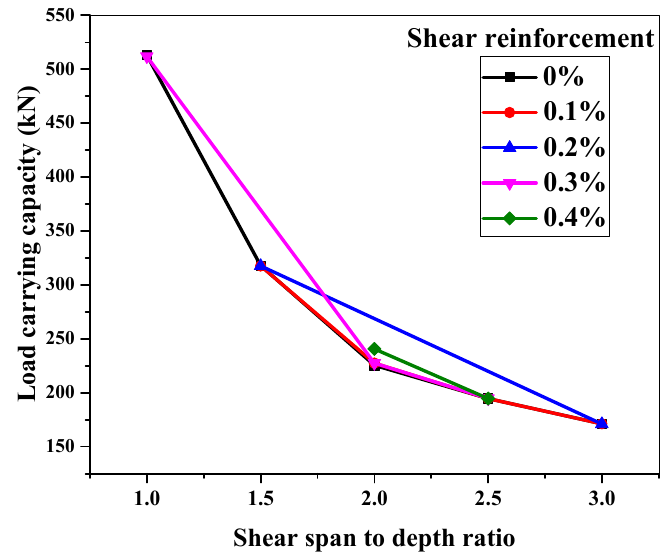
Figure 14. Effect of a/d ratio on the shear capacity of ECC beams.